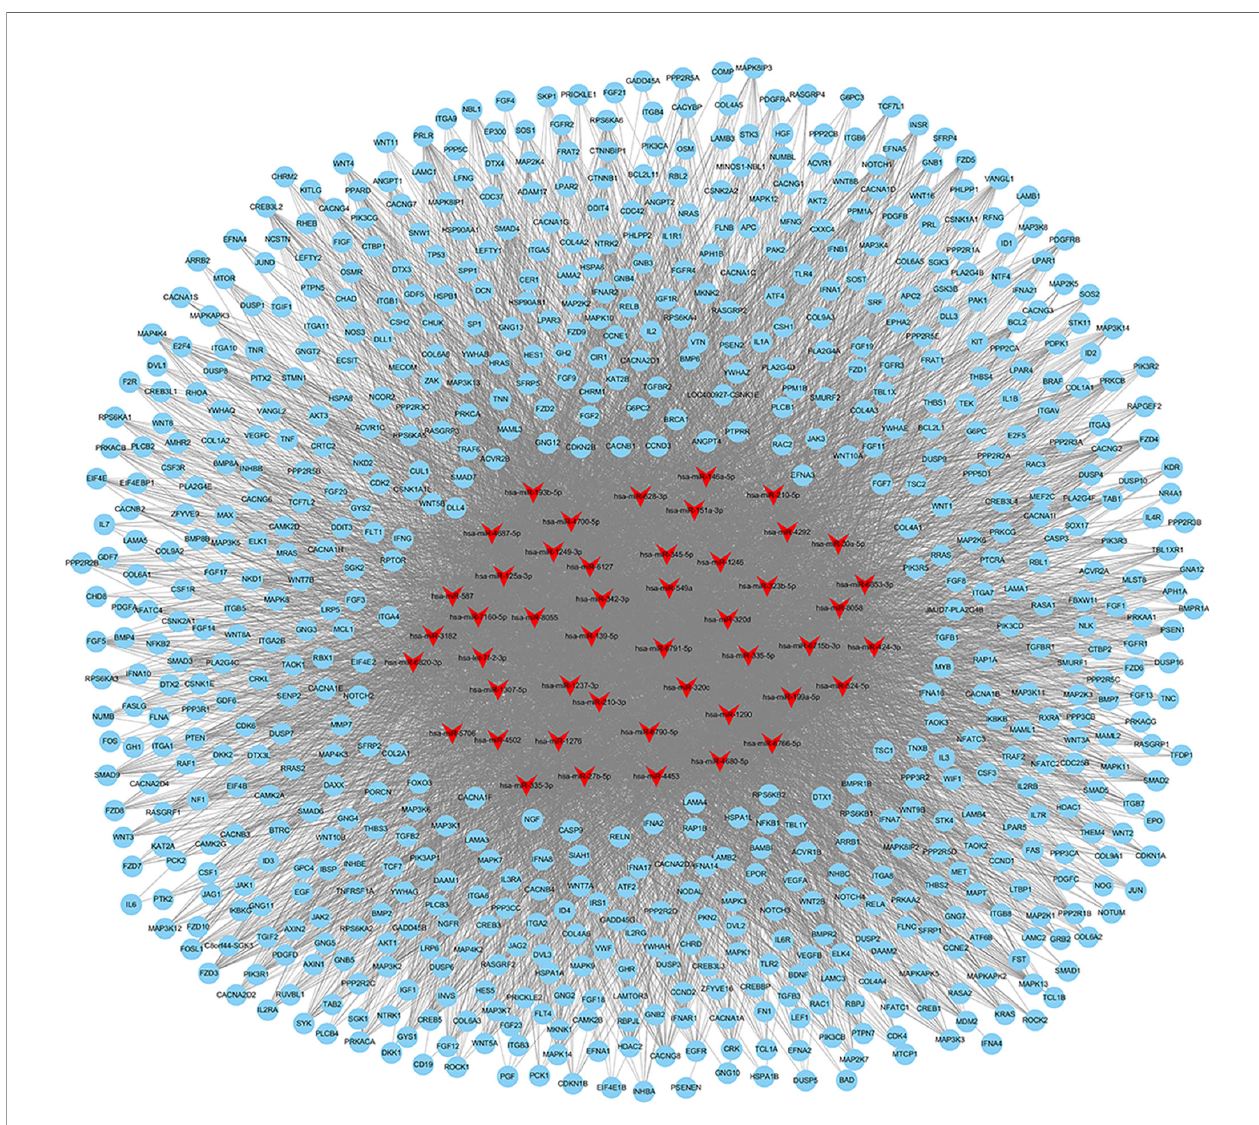
FIGURE 6 | Networks of 717 enriched pathways associated with 47 differentially expressed